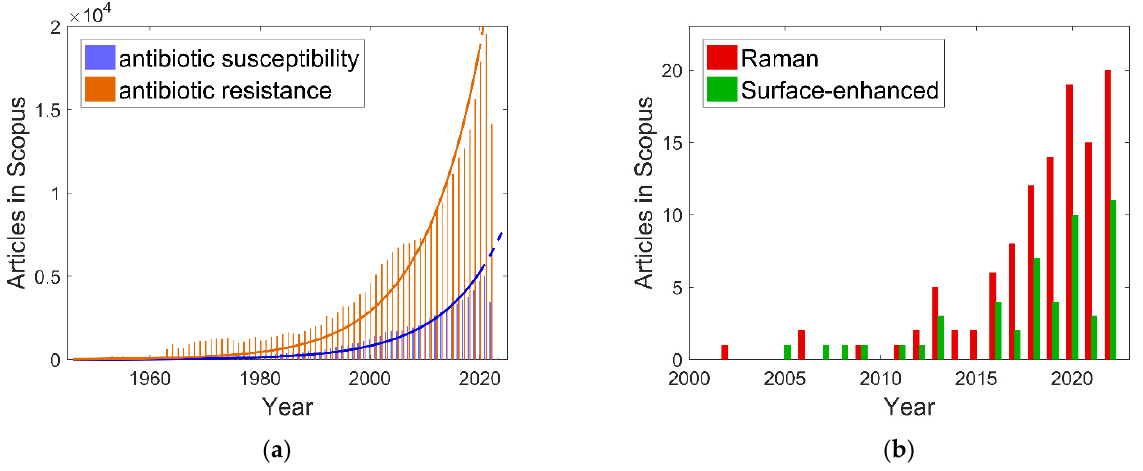
Figure 1. The number of papers indexed in Scopus per year: ( a ) queries “antibiotic AND susceptibility” (blue bars; the blue line is an exponential approximation) and “antibiotic AND resistance” (orange bars; the orange line is an exponential approximation); ( b ) queries “antibiotic AND susceptibility AND Raman” (red bars) and “antibiotic AND susceptibility AND surface-enhanced” (green bars).